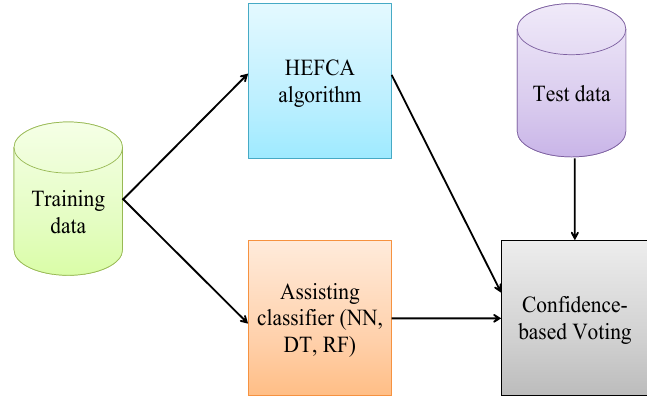
Figure 2. Flowchart of the Confidence-Based Voting.